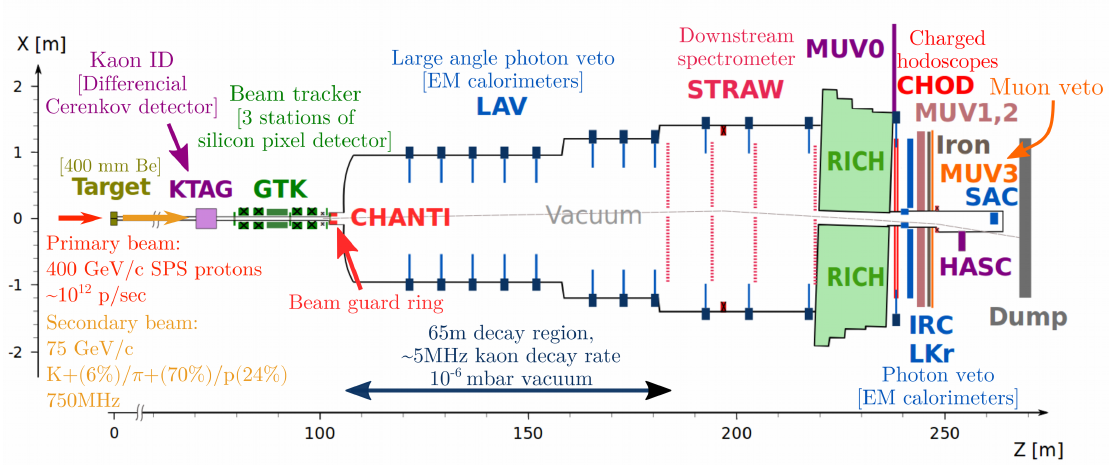
Figure 1. NA62 schematic layout; all the detectors are visible